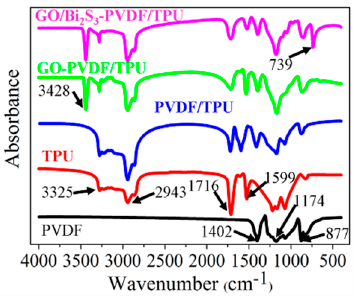
Figure 4. FTIR of different membranes.